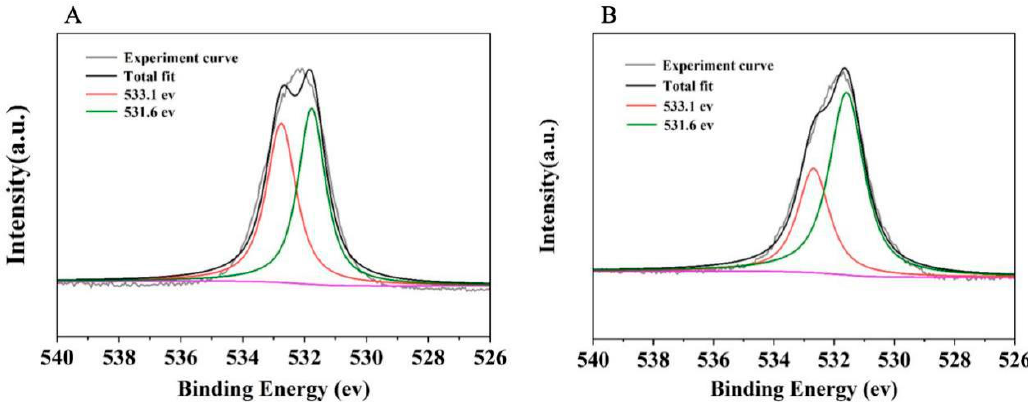
Figure 7. XPS spectra of O1s in FeAlg-ACF before ( A ) and after ( B ) its utilization in the FeAlg-ACF / PMS / visible light system. Reaction conditions: [FeAlg-ACF] = 2 g / L, [PMS] = 5 mmol / L, [azophloxine] = 50 µ mol / L, initial pH = 6.0, T = 25 °C.